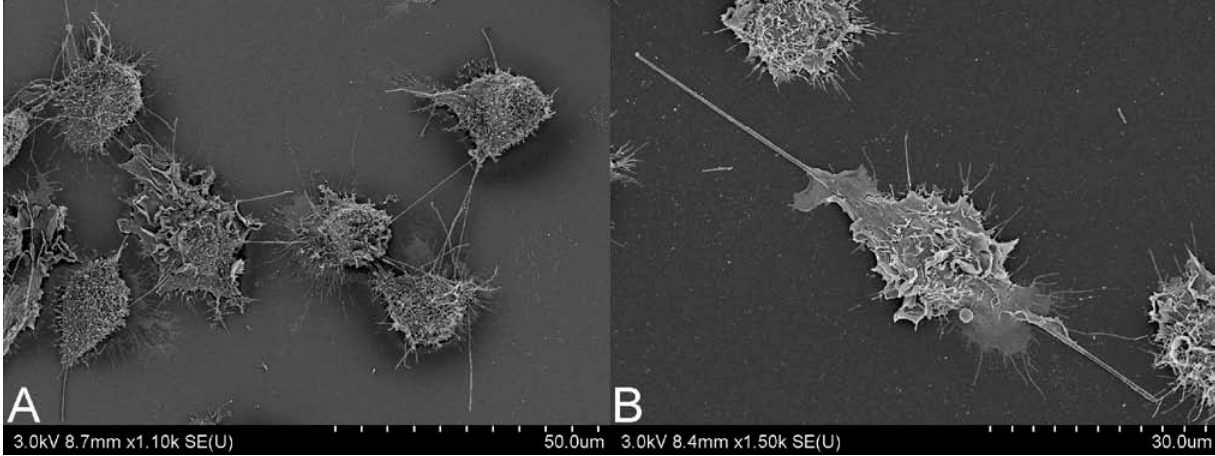
Figure 1. Scanning electron microscopy image of J774.A1 cells undergoing frustrated phagocytosis, induced by ( A ) multi-walled carbon nanotubes and ( B ) long fiber amosite asbestos. Scale bar is on bottom right of each image. Images courtesy of Matthew Boyles, Lesley Young and Vicki